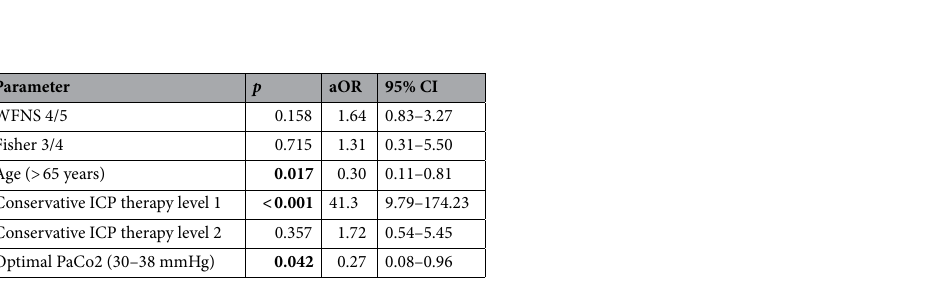
Table 3. Multivariate analysis of factors affecting the need for DC. Statistically significant p -values are marked bold.